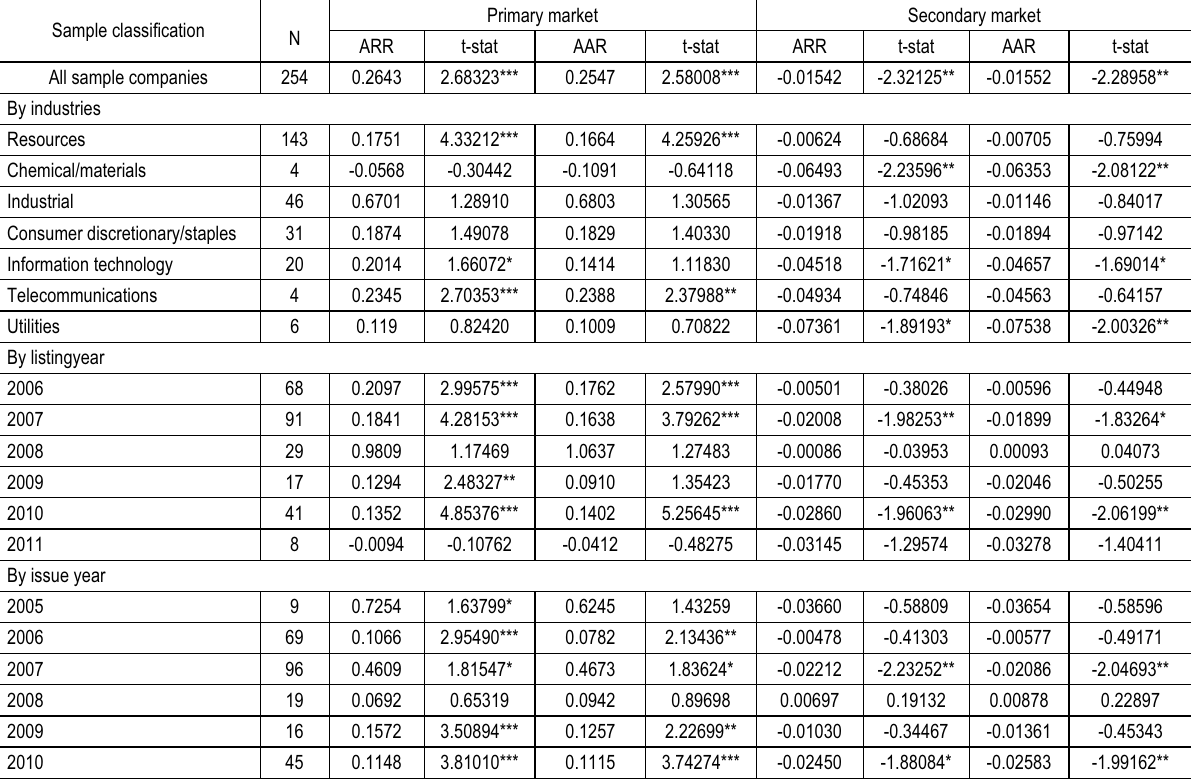
Table 3. First-day returns: primary and secondary